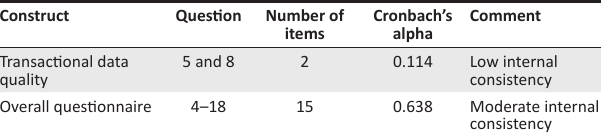
TABLE 1: Cronbach’s alpha coefficients on questionnaire